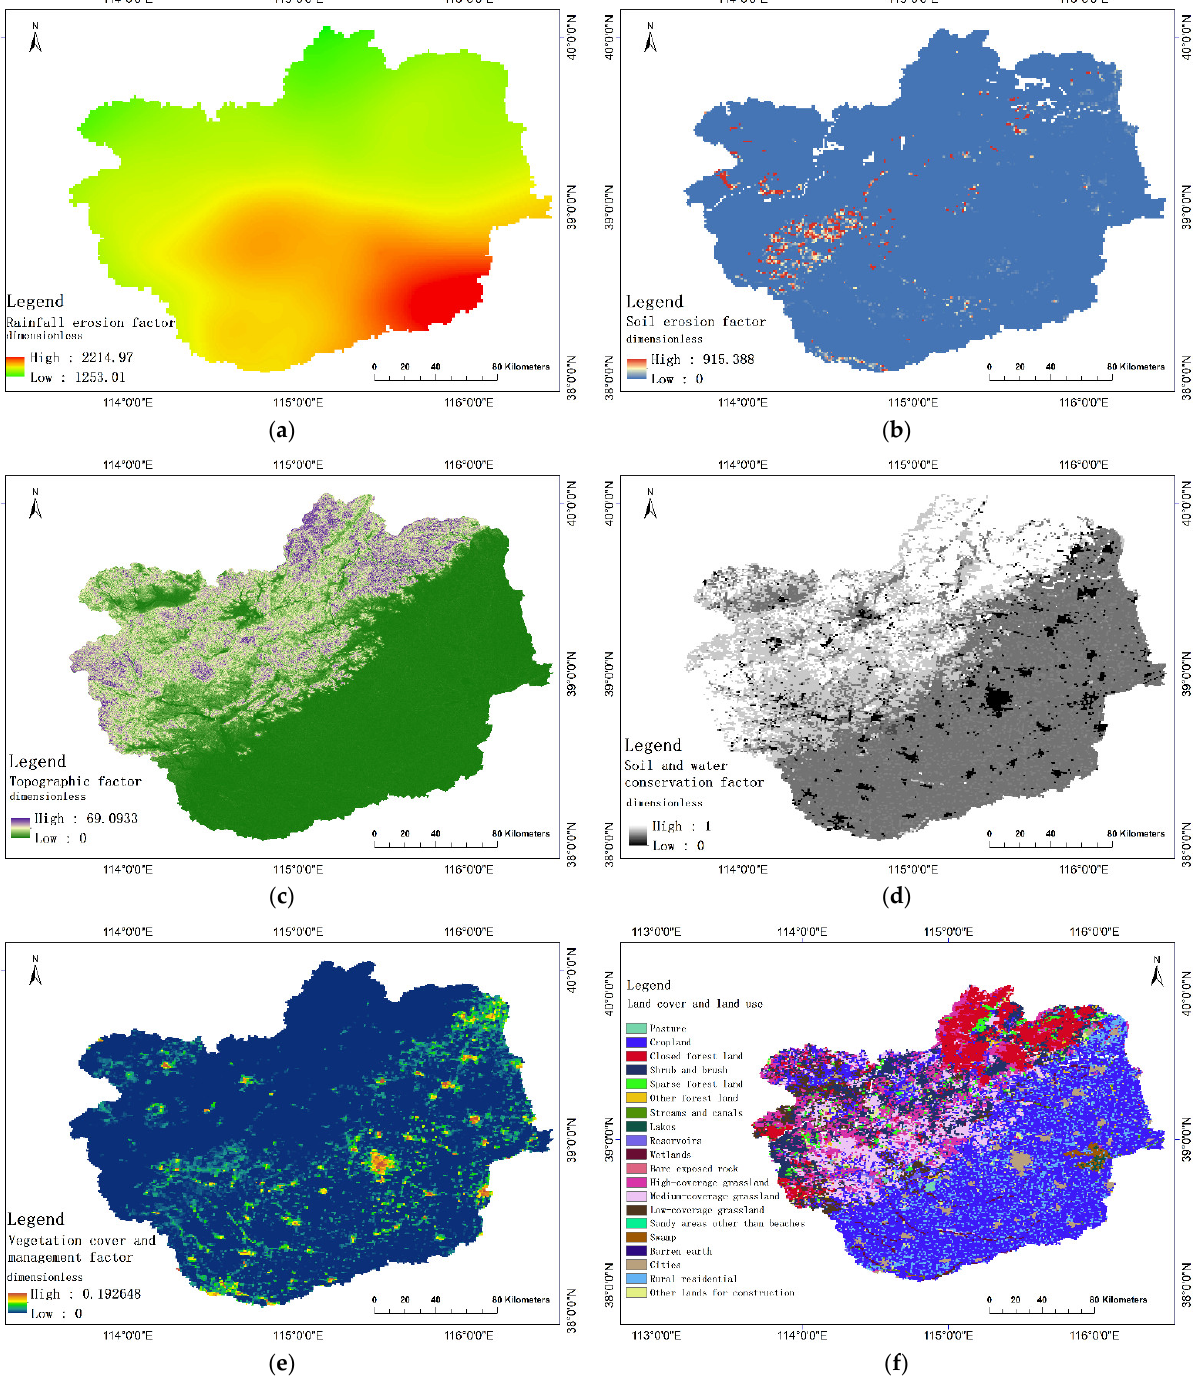
Figure 3. Calculation results of parameters in RUSLE model in the study area: ( a ) Rainfall erosion, ( b ) Soil erosion factor, ( c ) Topographic factor, ( d ) Soil and water conservation factor, ( e ) Vegetation cover factor, ( f ) Land use type.